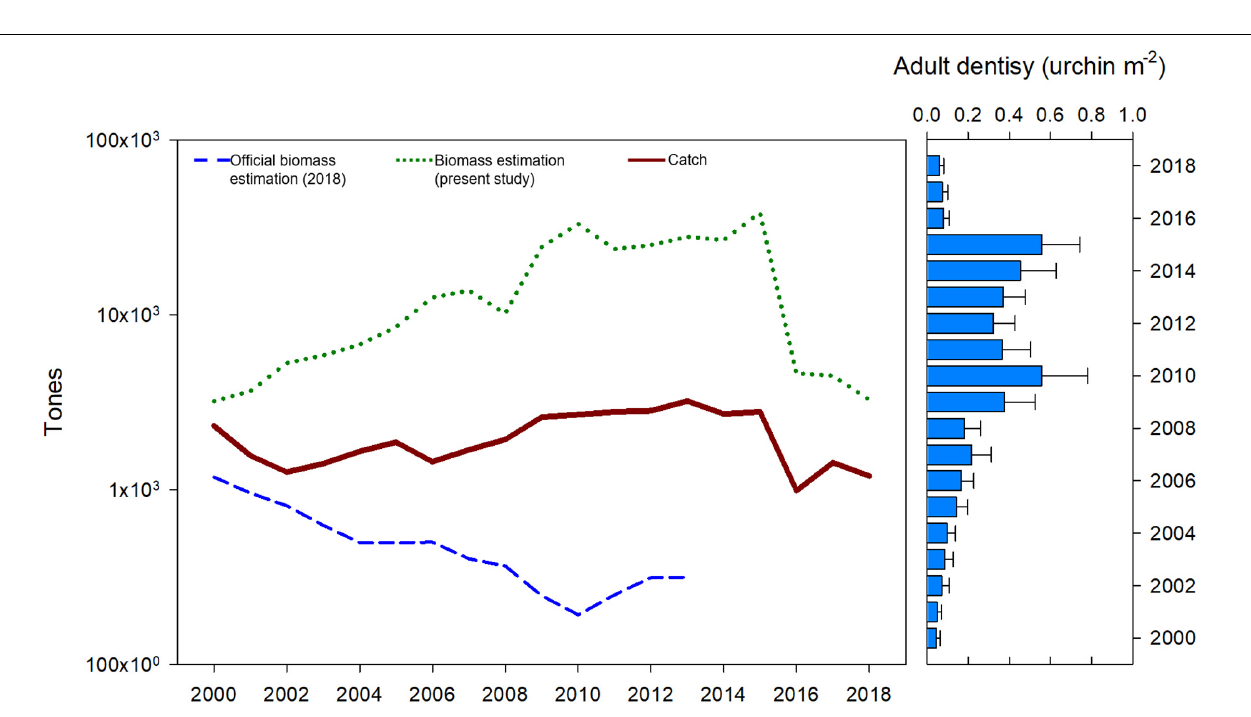
Frontiers in Marine Science |